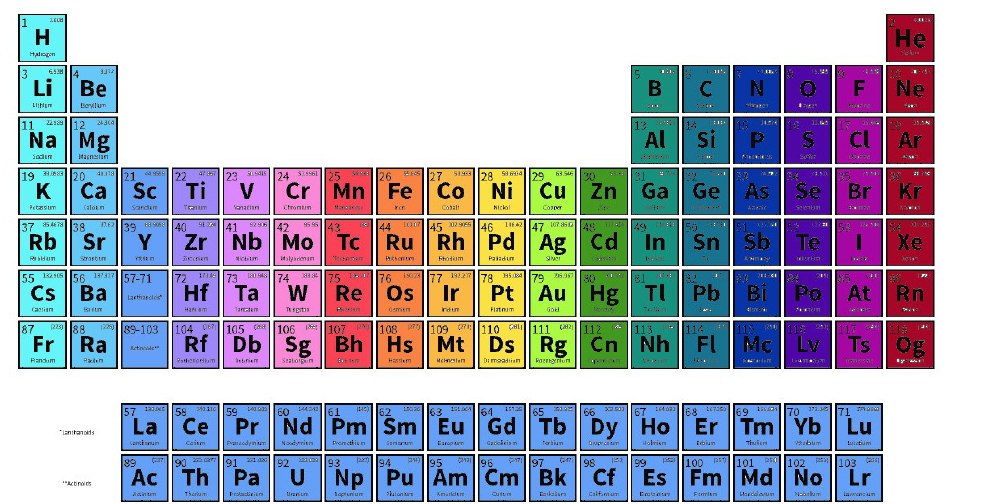
Figure 4. Grouping of atom according to their chemical family. Each color represents a single atom